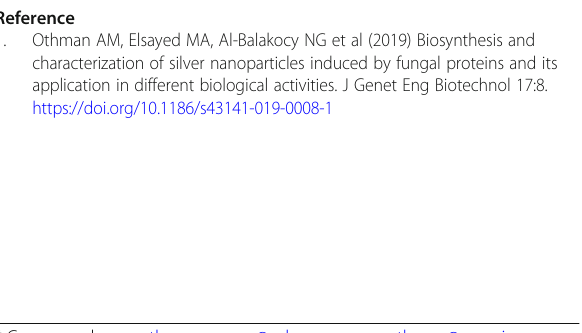
Fig. 6 Antimicrobial activity of the AgNPs biosynthe- sized by means of A. fumigatus CFF mediation. (1) AgNPs sample formed at pH 6.0, (2) at pH 8.0, (3) at pH 10.0, (4) at pH 12.0, and (5) cell free